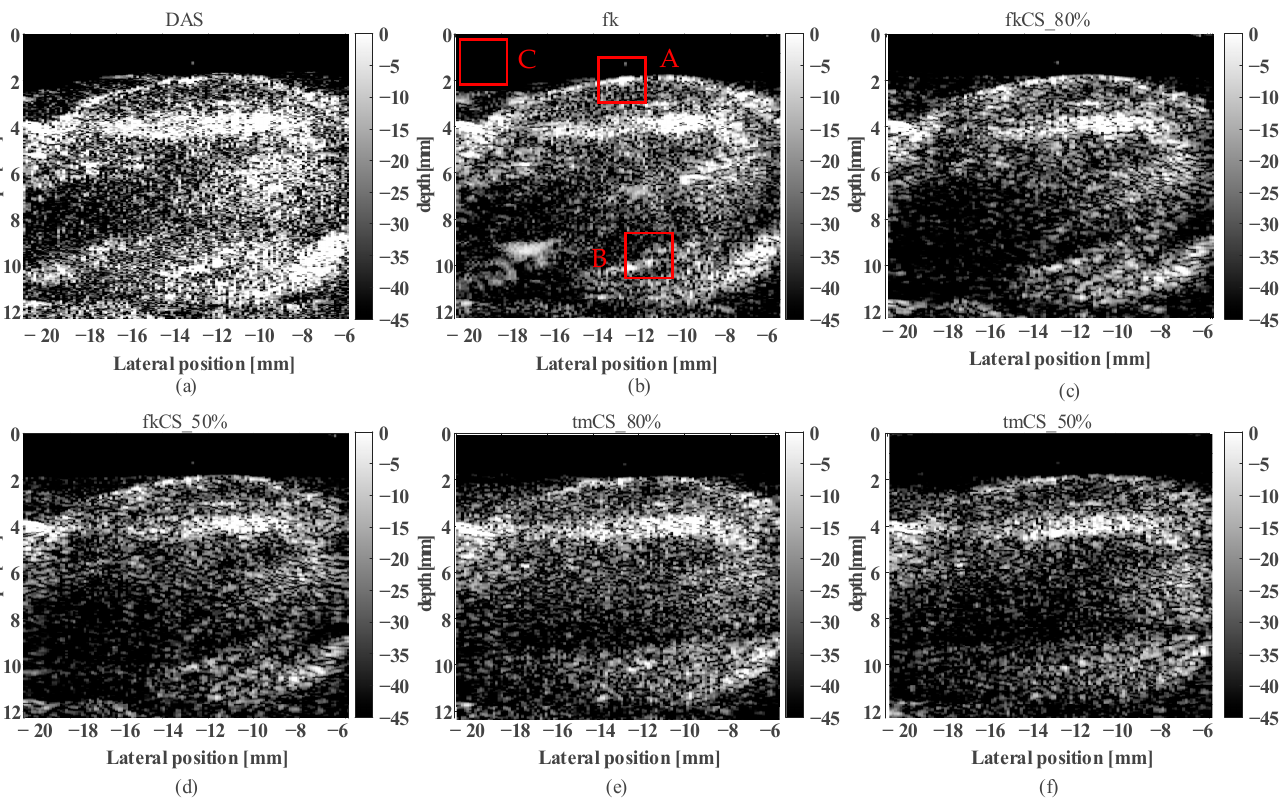
Figure 9. B mode images based on different beamformers: ( a ) DAS, ( b ) Stolt’s f-k, ( c ) fkCS with compression rate of 80%, ( d ) fkCS with compression rate of 50%, ( e , f ) are tmCS with compression rates of 80% and 50%, respectively. Table 3. PSNR of different beamformers on heart scan.